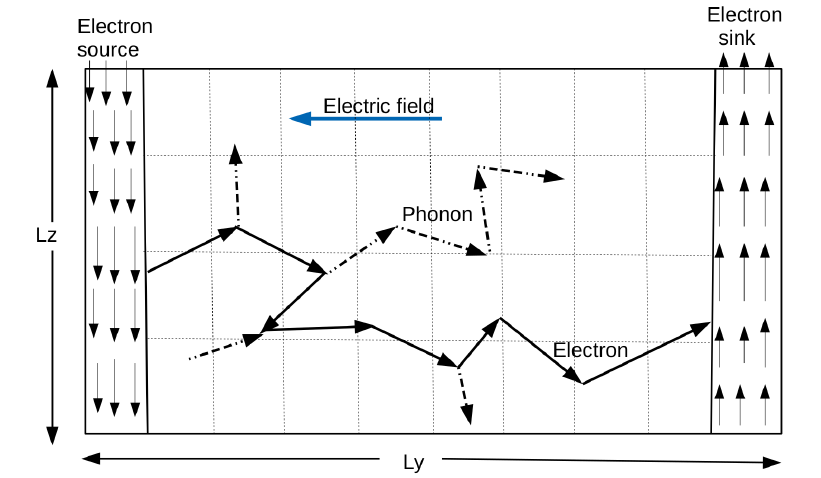
Figure 1. Front/source and rear/sink boundaries are set to be isothermal at room temperature. Lateral boundaries are shown to be